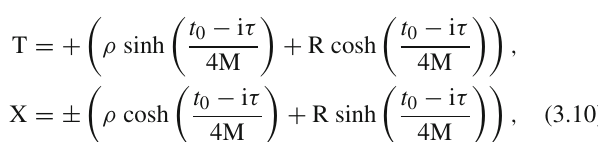
Fig. 6 Lapse function